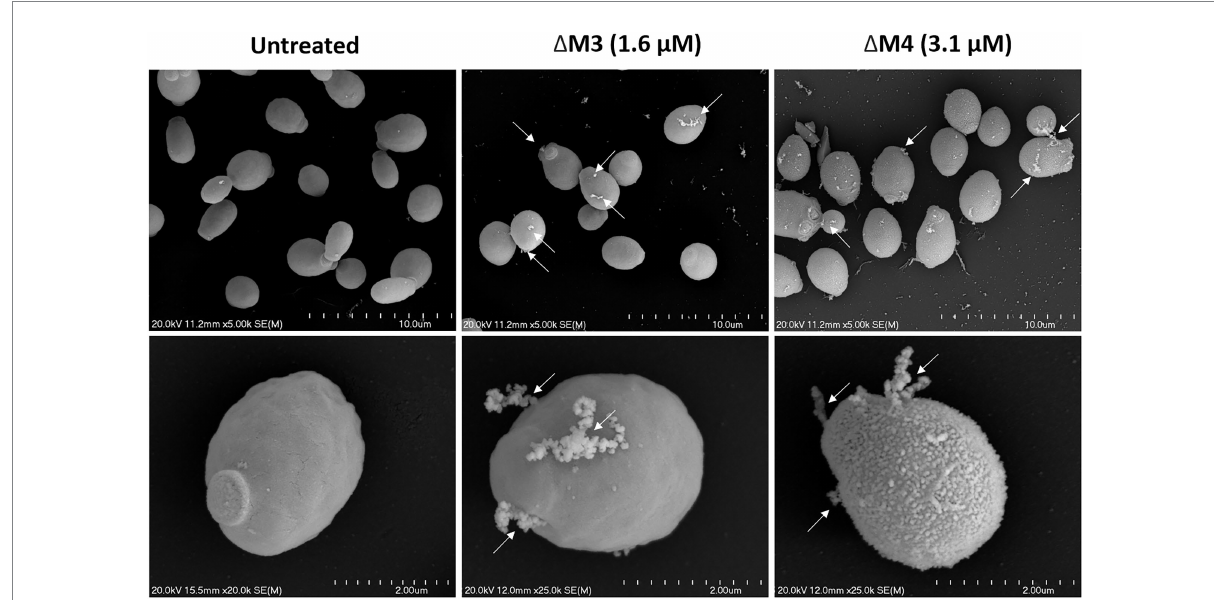
FIGURE 4 Scanning electron microscopy of the C. albicans cell surface after treatment with Δ M3 and Δ M4. C. albicans yeast cells (10 5 /100 μ l) were incubated with Δ M3 (1.6 μ M) or Δ M4 (3.1 μ M) in 10 mM HEPES pH 7.0 with 5 mM glucose for 2 h at 30 ° C, then fixed overnight with glutaraldehyde, dehydrated, coated with gold and examined with a scanning electron microscope HITACHI S-4700. Cells incubated in buffer without peptides served as an untreated control. Arrows indicate surface damage that leads to intracellular material